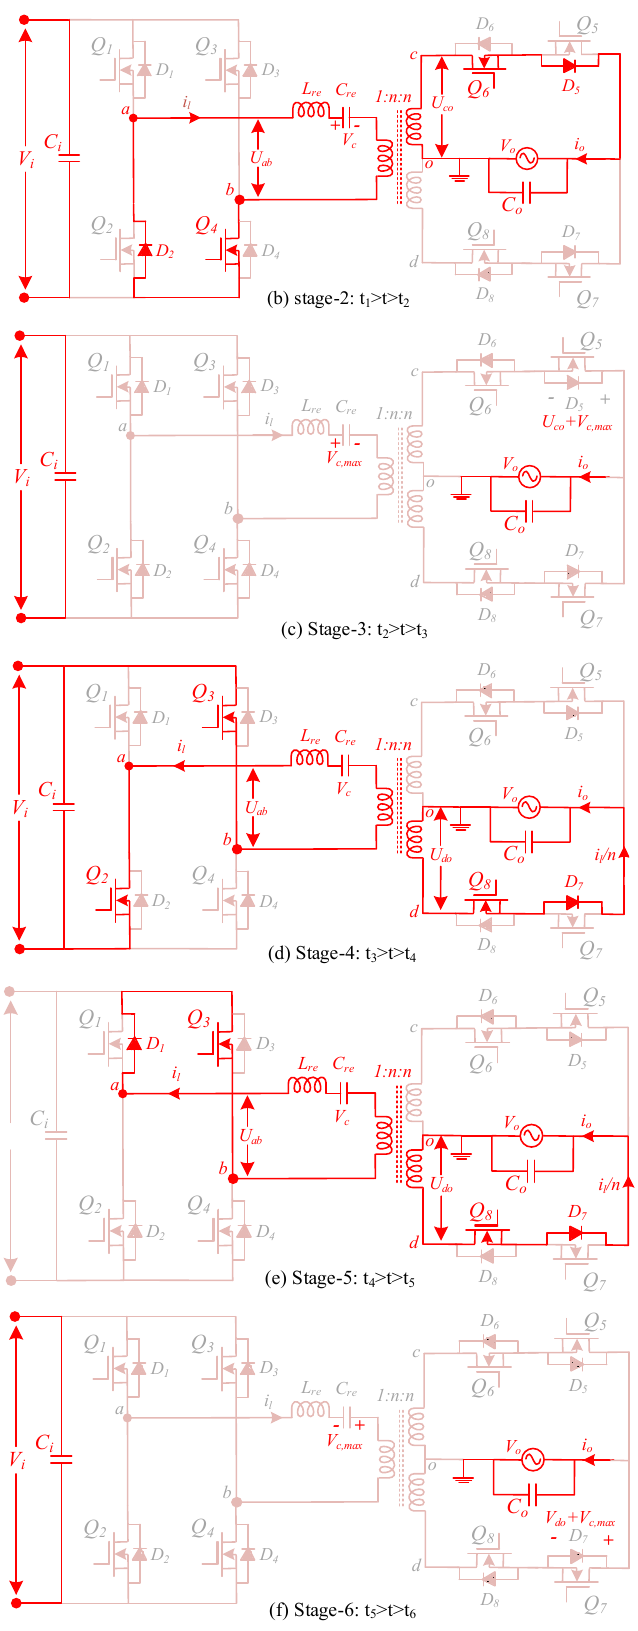
Figure 3. Working stages of proposed converter ( V o > 0).